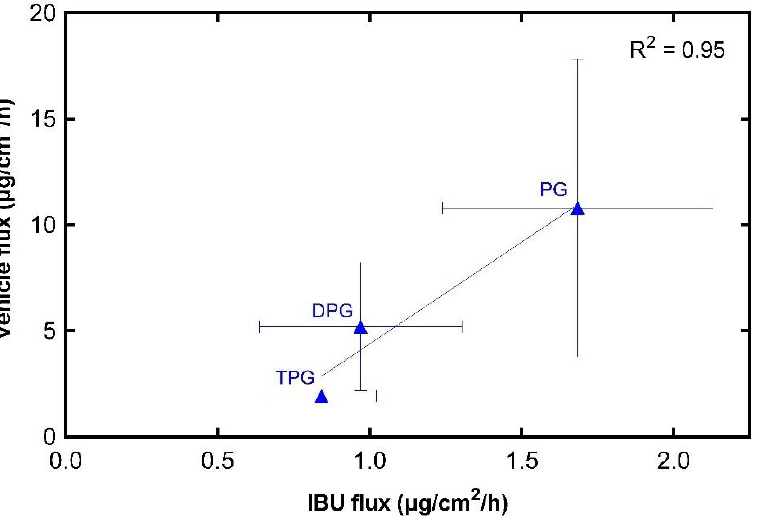
Figure 6. Correlation of maximum vehicle flux and maximum IBU flux through human epidermis (mean ± SD, n = 5).